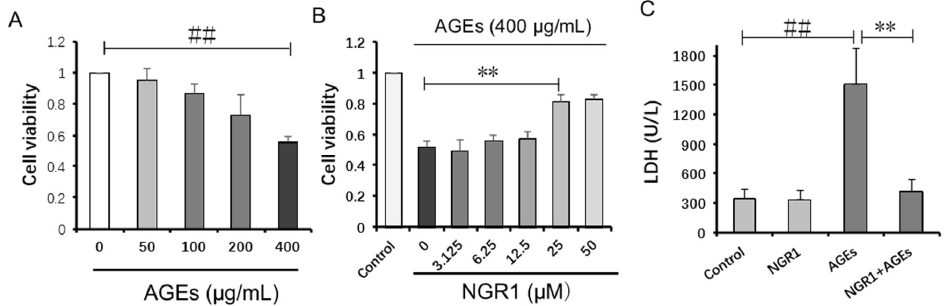
Figure 6. NGR1 attenuated AGE-induced HK-2 cell death. ( A ) HK-2 cell viability was reduced by incubation with AGEs for 24 h; ( B ) NGR1 attenuated HK-2 cell death induced by AGEs; ( C ) NGR1 decreased HK-2 cell lactate dehydrogenase (LDH) release induced by AGEs. All data are presented as the mean ± SD of three independent experiments ( n = 9). ## p < 0.01 vs. the control group; ** p < 0.01 vs. the AGE group.